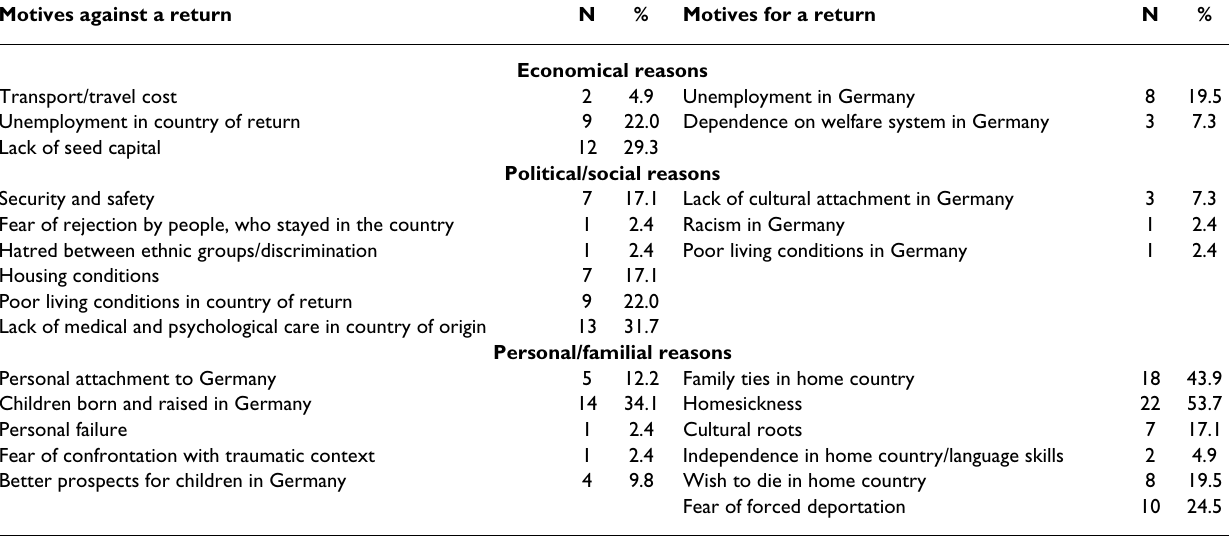
Economical reasons